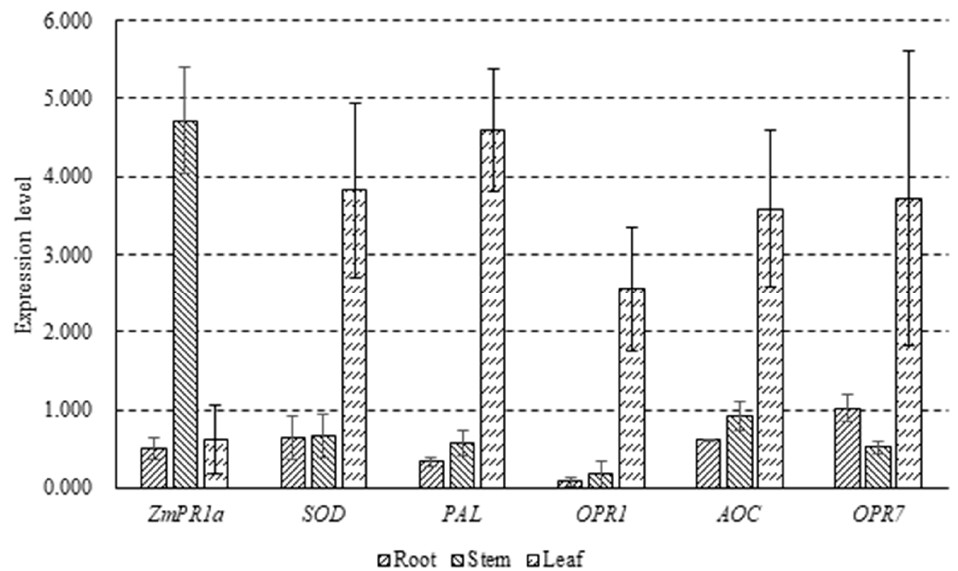
Figure 3. Expression analysis of maize disease resistance genes in different issues after being in- duced by P. polymyxa strain SF05 compared to the control group. The error bars in the figure are mean ± standard deviation.